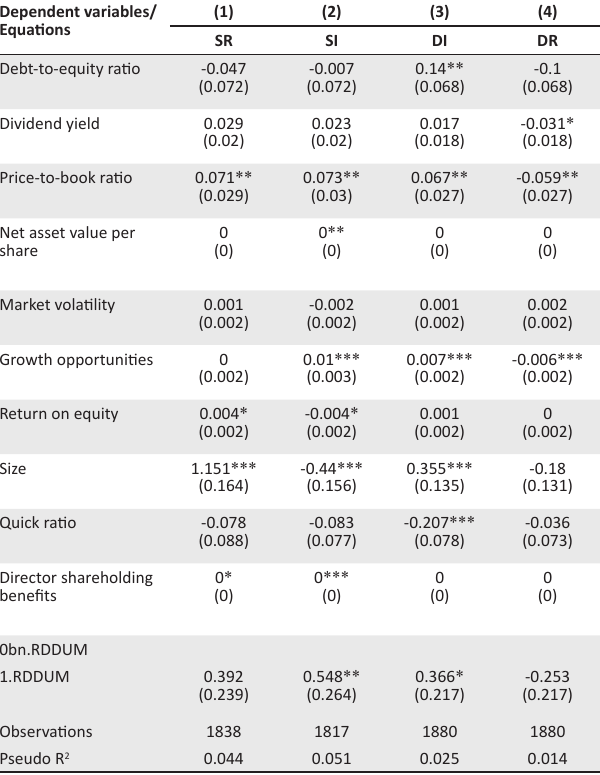
TABLE 4: Determinants of companies’ choices between financing decisions per transactions. Dependent variables/